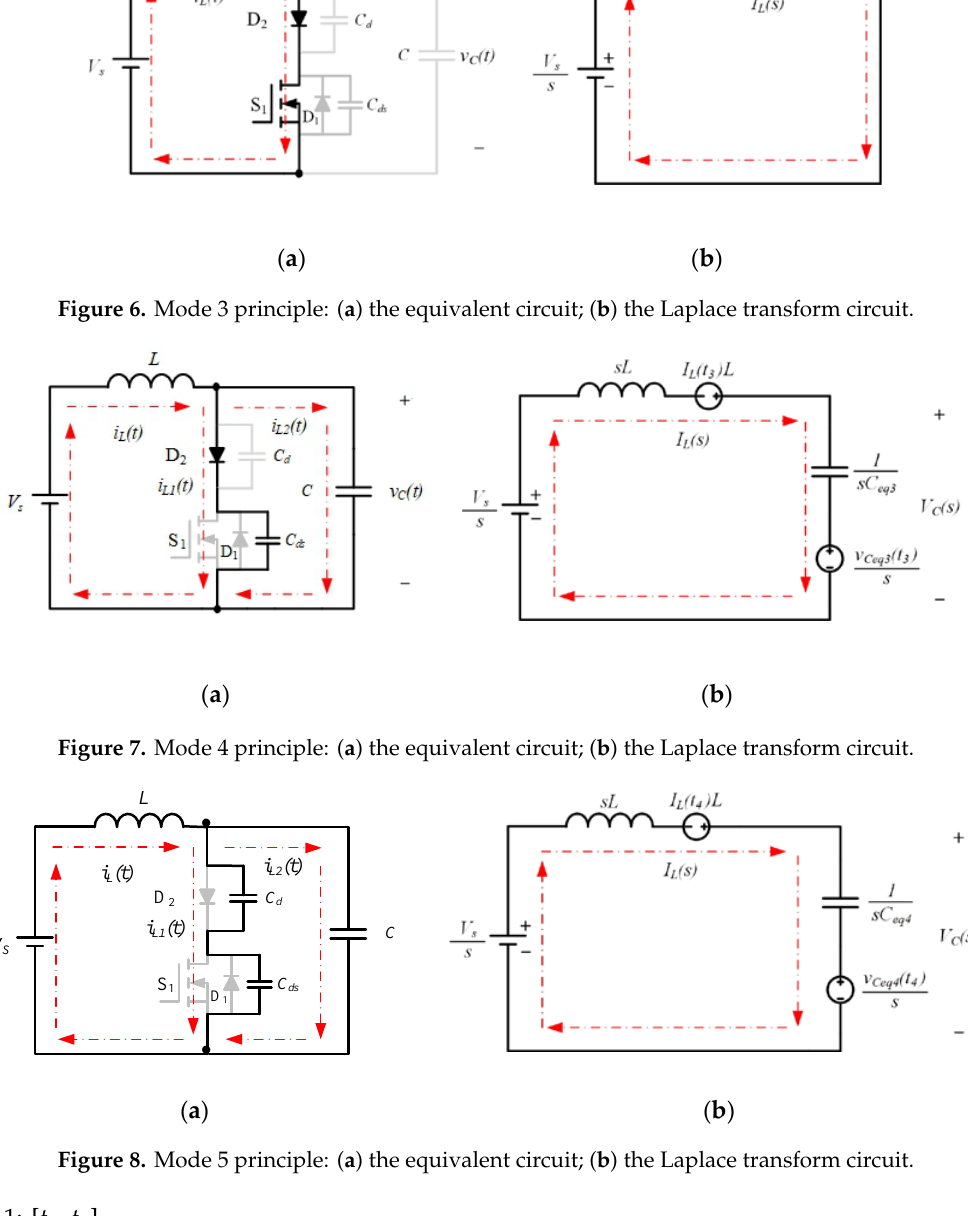
Figure 8. Mode 5 principle: ( a ) the equivalent circuit; ( b ) the Laplace transform circuit.